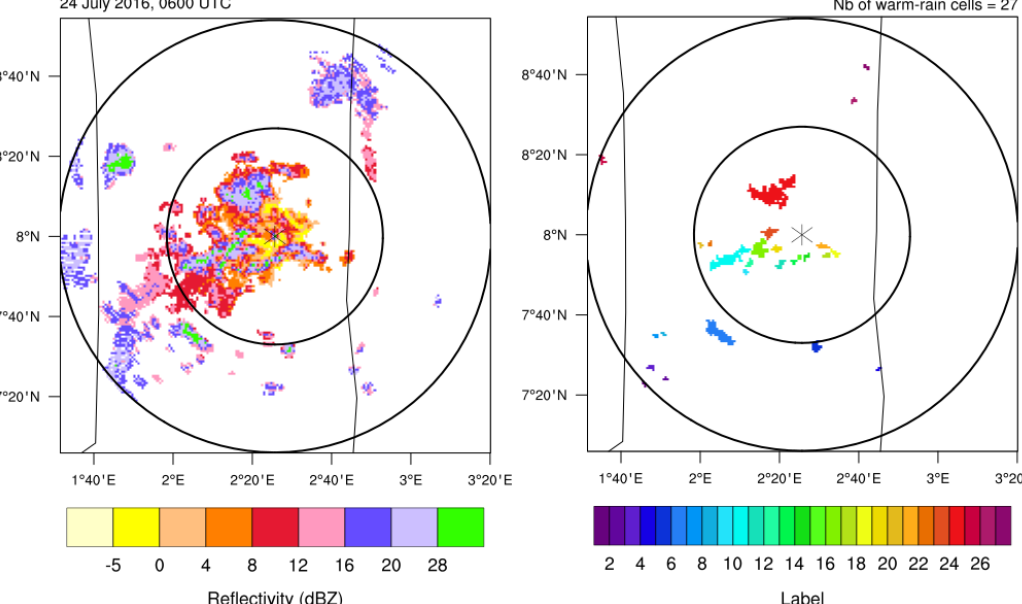
Figure 4. Left: horizontal projection of maximum reflectivity as retrieved from the X-band radar. Right: warm-rain cells detected with the clustering algorithm described in Section 2.3, labeled from 1 to 27. The inner and outer circles have 50- and 100-km radius,